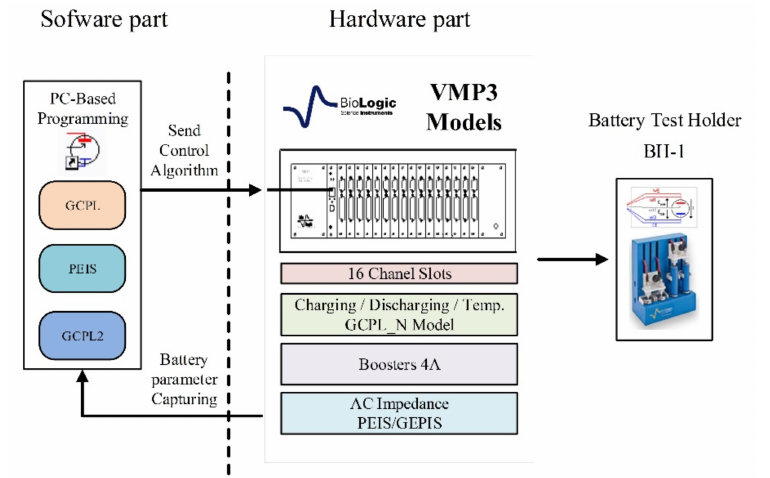
Figure 2. Battery testing